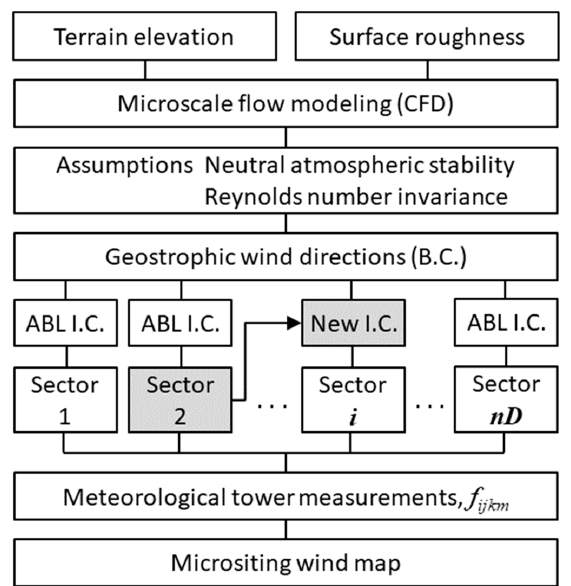
Figure 1. Flow chart of the micro-siting wind mapping procedure.